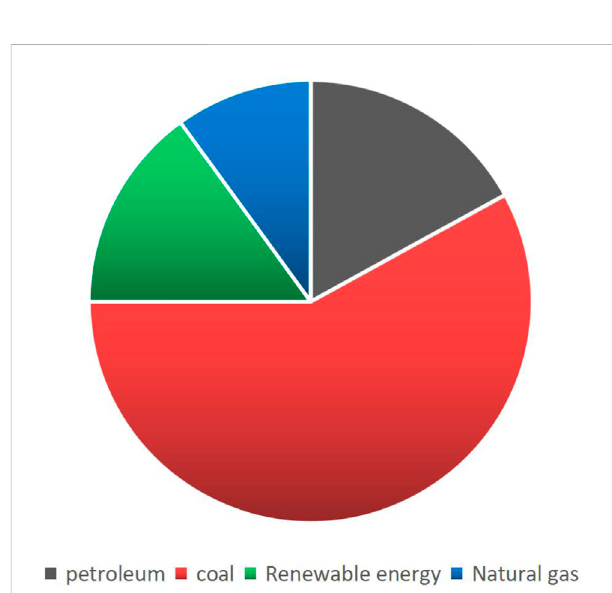
FIGURE 2 China ’ s energy structure in 2020. Data source: The data in the fi gure is calculated according to the China Energy Statistical Yearbook (2001 – 2019). The author uses the of fi ce software excel (one of the Of fi ce components in theOf fi ce software packagedeveloped by Microsoft in United States) to